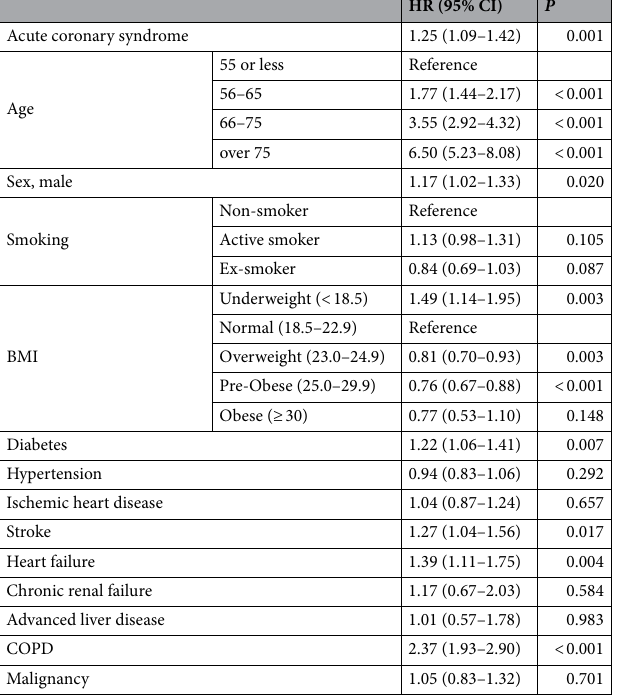
Table 2. Standard Cox regression model of the first pneumonia event. BMI: Basal mass index; COPD: Chronic obstructive pulmonary